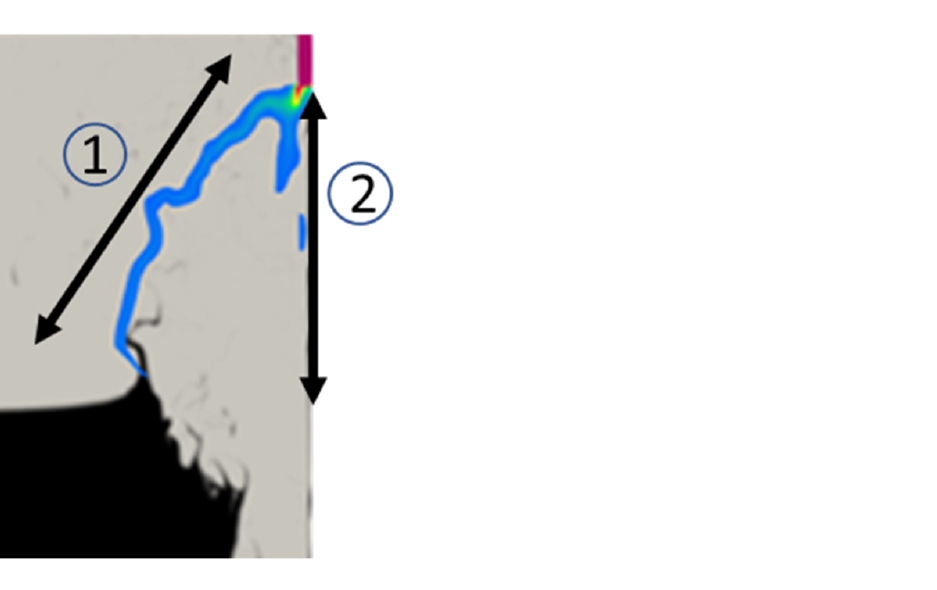
Figure 3. Electric arc during the impingement of the liquid metal: (1) actual arc length; (2) arc gap. Table 2. Induction equation boundary conditions for the domain.